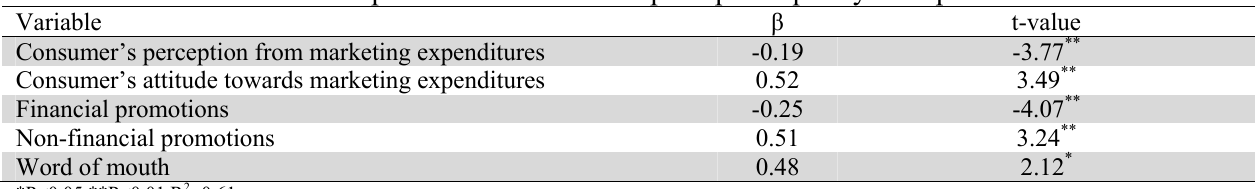
Variable Consumer’s perception from marketing expenditures